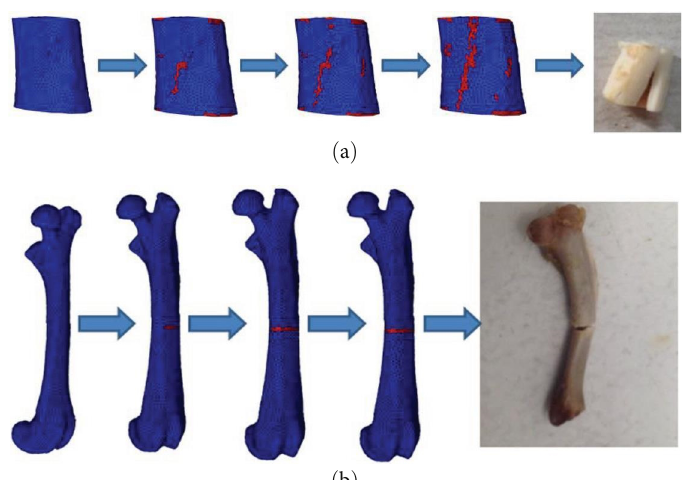
F IGURE 3: Comparison of the fracture patterns between the simulations and experiments: (a) the failure process in the compression simula- tion; (b) the failure process in the three-point bending